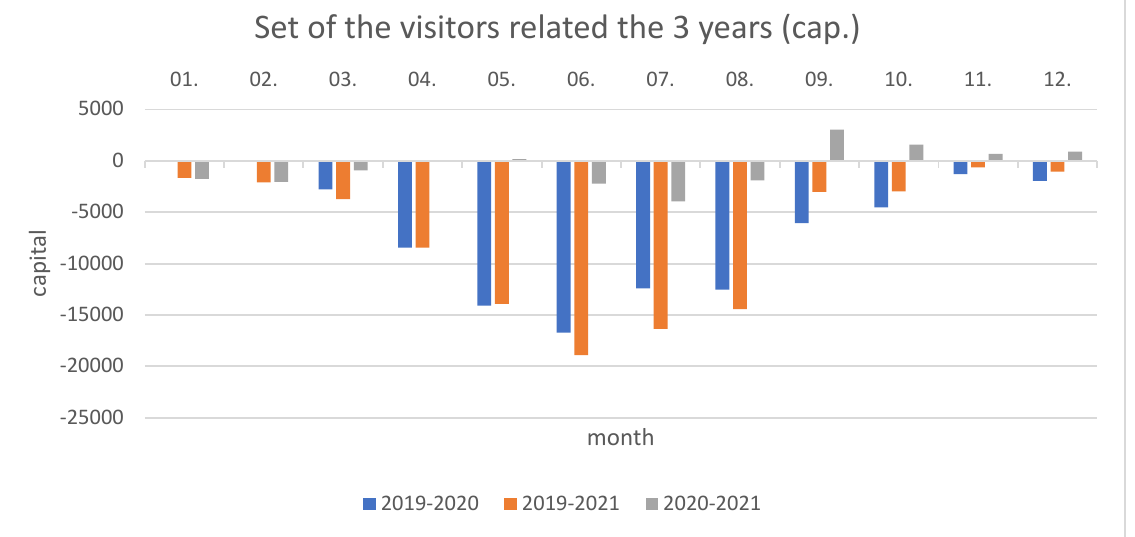
Figure 5. Decline in the number of visitors. Resource: own design based on the dataset of the Benedictine Abbey in Tihany.